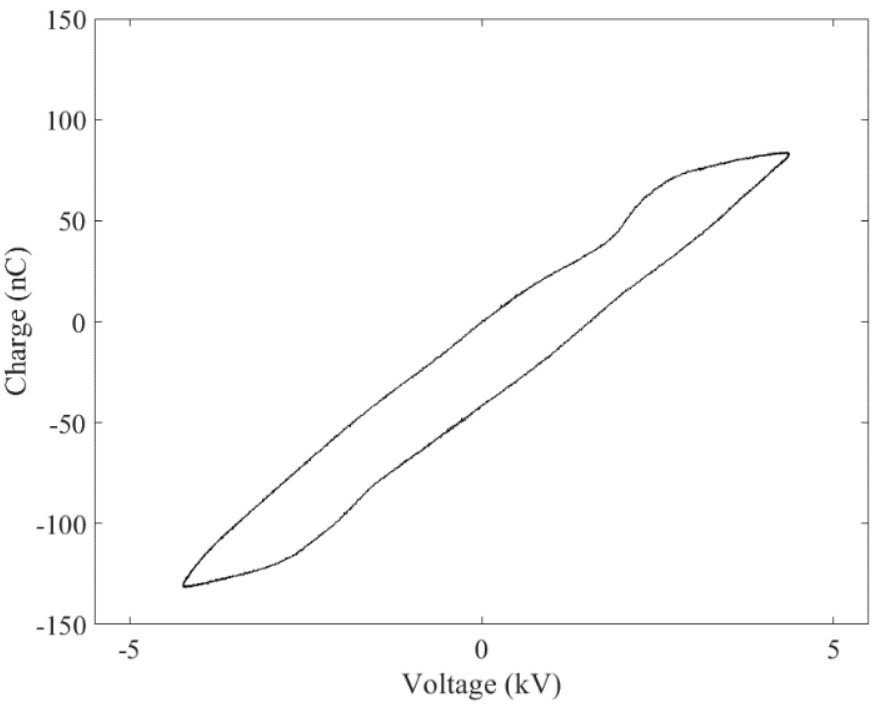
Figure 3. Lissajous diagram of the APPJ.